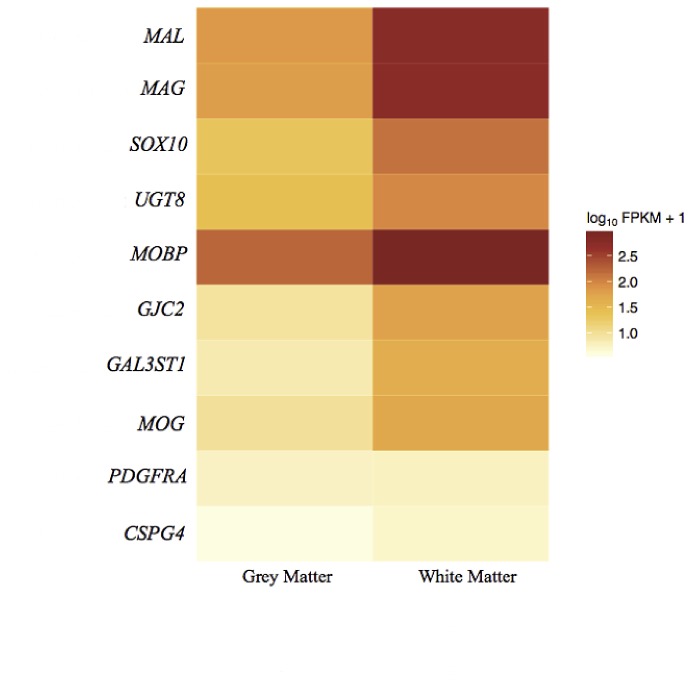
Heatmap of gene expression of oligodendrocyte cell markers.Shows the expression profile of oligodendrocyte cell markers in GM and WM. There was an expression bias towards WM with the up-regulation of SOX10, GJC2, MOG, MAG, MAL, GAL3ST1, UGT8 being statistically significant (q-value<0.05).